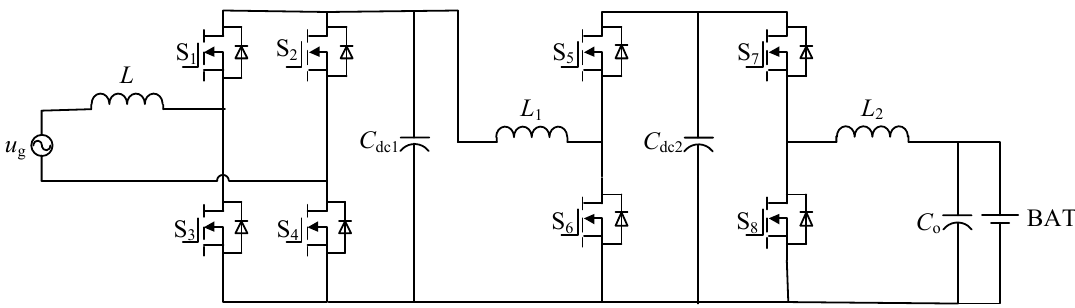
Figure 2. Topology of non-isolated on-board bidirectional charger composed of PWM converter and cascaded buck-boost DC-DC